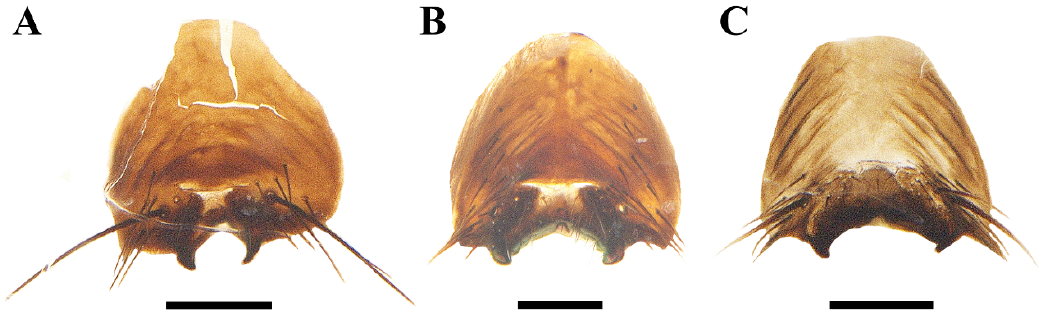
Figure 5. Ventral view of sternite 5 of Macquartia spp. ( A ) M. brunneisquama sp. nov. ( B ) M. chinensis sp. nov. ( C ) M. flavipedicel sp. nov. Scale bar = 0.2 mm.